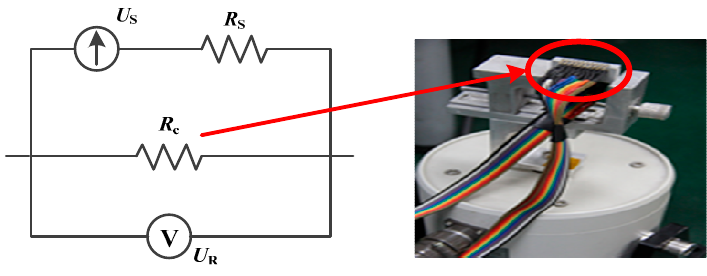
Figure 9. Test principle of contact resistance of four line method.